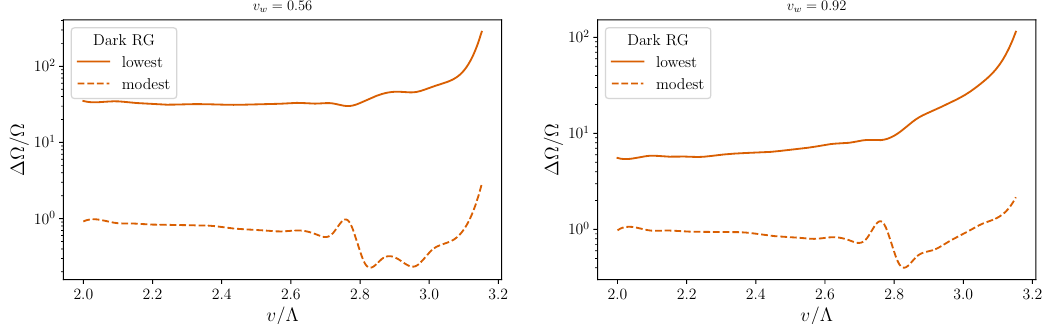
Figure 9 . Dark RG : the relative error when using the lowest and modest levels of diligence, compared to the highest level of diligence (for which ∆Ω / Ω = 0 ). The vertical axis shows the peak (frequency-independent) gravitational wave energy density for detonation. The precise definition of ∆Ω / Ω is given in eq. (4.1). The horizontal axis corresponds to the ratio of the tree level v.e.v to the cut off scale v/ Λ . ∆Ω / Ω is displayed for deflagration and detonation at different levels of diligence using eq. [(2.7), (2.15), (2.61)] and eq. (4.1). The temperatures are set to T